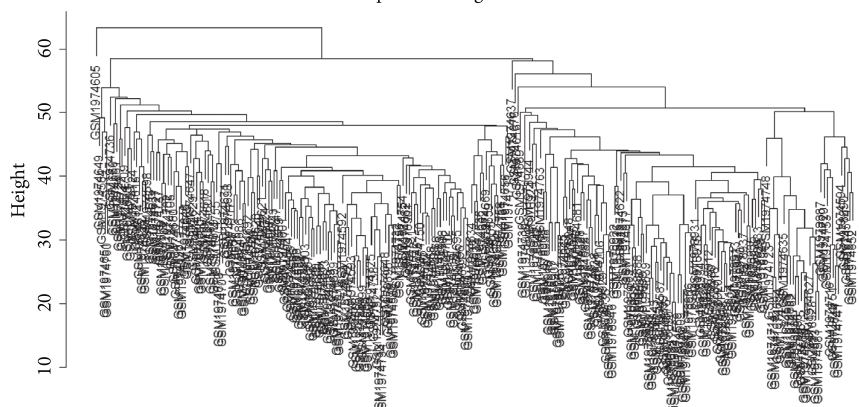
Figure 3: Decision tree for sample data.